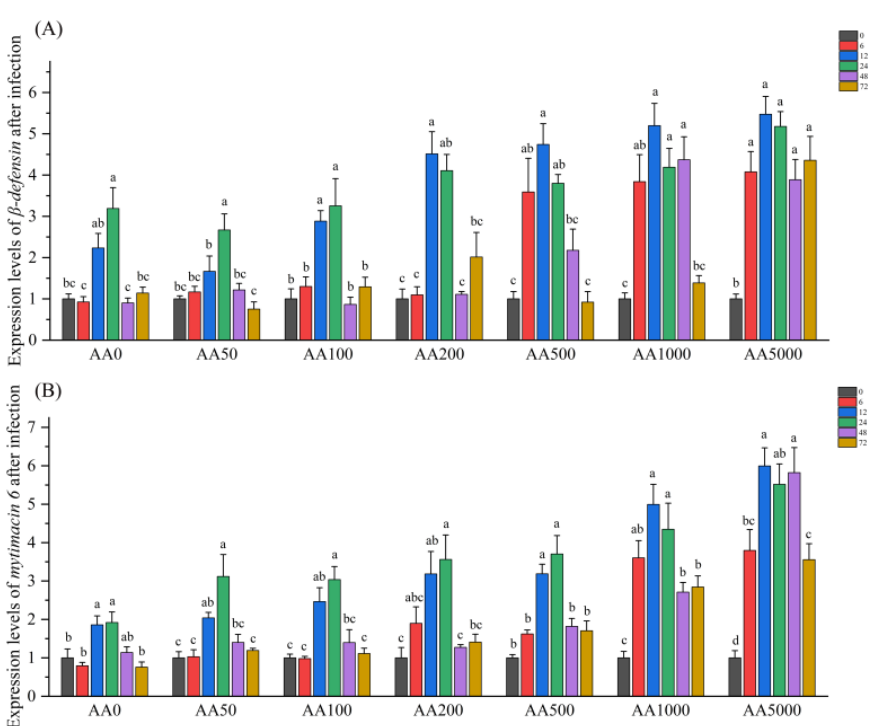
Figure 5. Expression levels of β-defensin and mytimacin 6 in the digestive gland of abalone ( Haliotis discus hannai ) in response to Vibrio Parahemolyticus after a 100-day feeding trial. ( A ) β-defensin ; ( B ) mytimacin 6 . Gene expression levels are presented as the fold-change compared with the respective control group (AA0) (set to 1) at 0 h, 6 h, 12 h, 24 h, 48 h and 72 h post-infection. All data expressed as mean ± SE ( n = 3). The different lowercase letters indicate significant differences ( p <